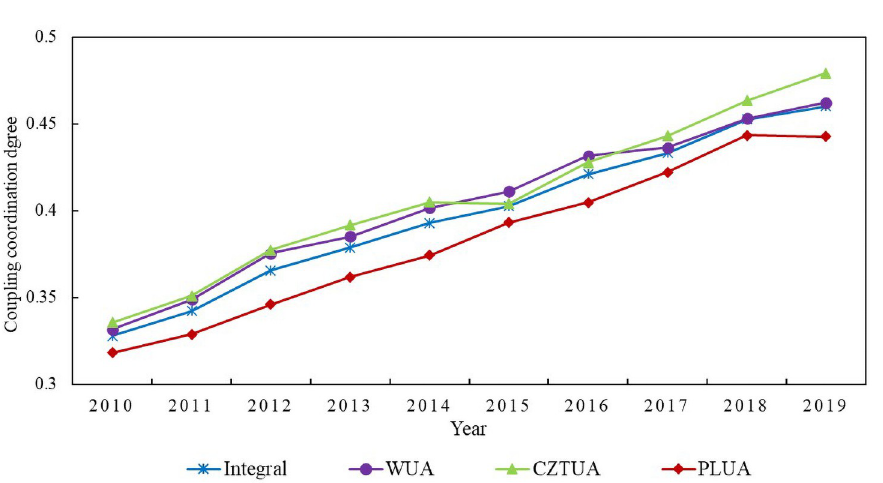
Fig 2. Temporal evolution of the coupling coordination degree between economic resilience and high-quality economic development in the UAMRYR. Note: WUA–Wuhan urban agglomeration, CTZUA–Chang-Zhu-Tan urban agglomeration, PLUA–Poyang Lake urban